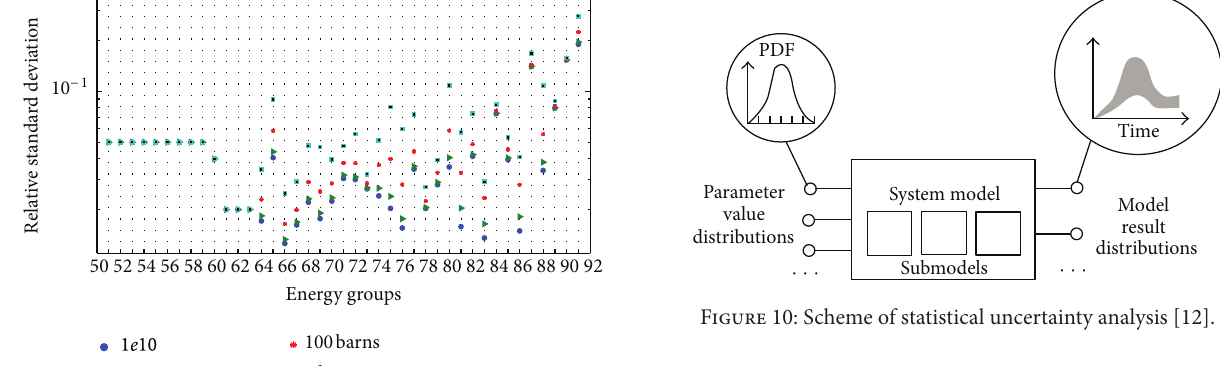
U reaction. 235 (𝑛𝑛𝑛𝑛𝑛𝑛